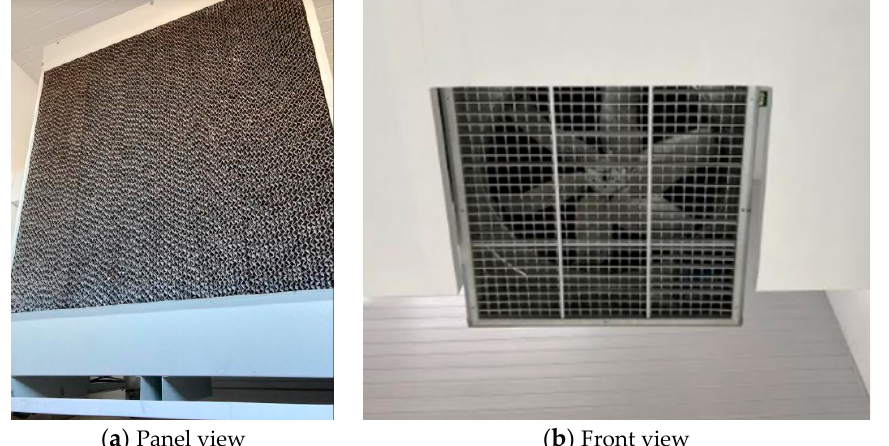
Figure 2. Munters Bb 150 evaporative equipment.